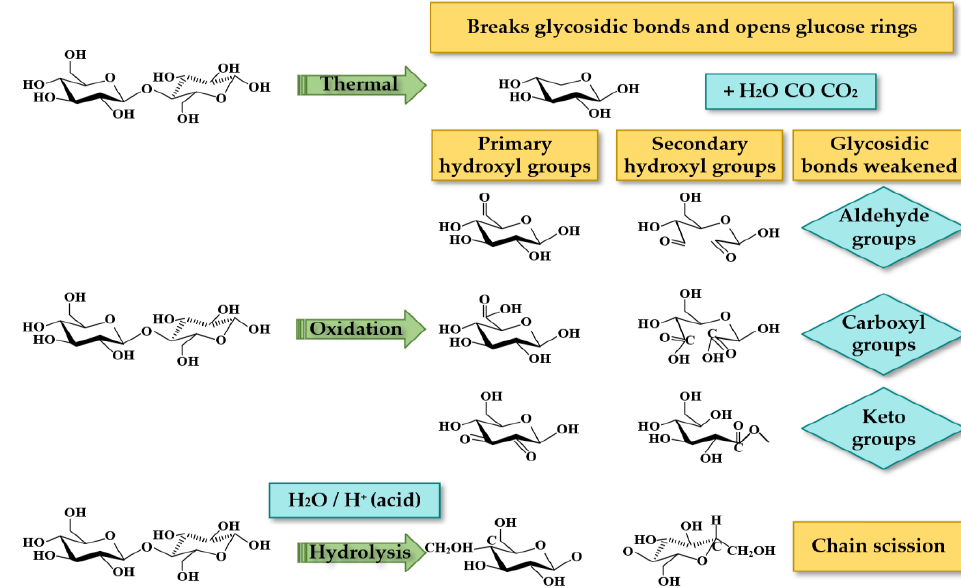
Figure 3. Classification of cellulose degradation types and their degradation processes.